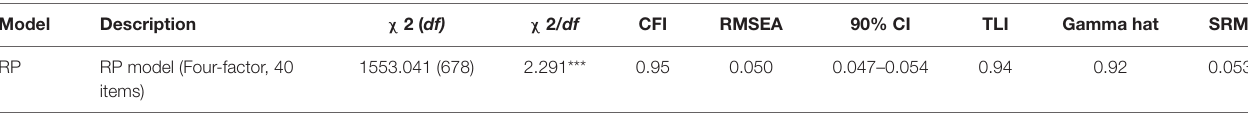
TABLE 13 | Results of the Structural Equation Modeling (SEM) for research productivity.